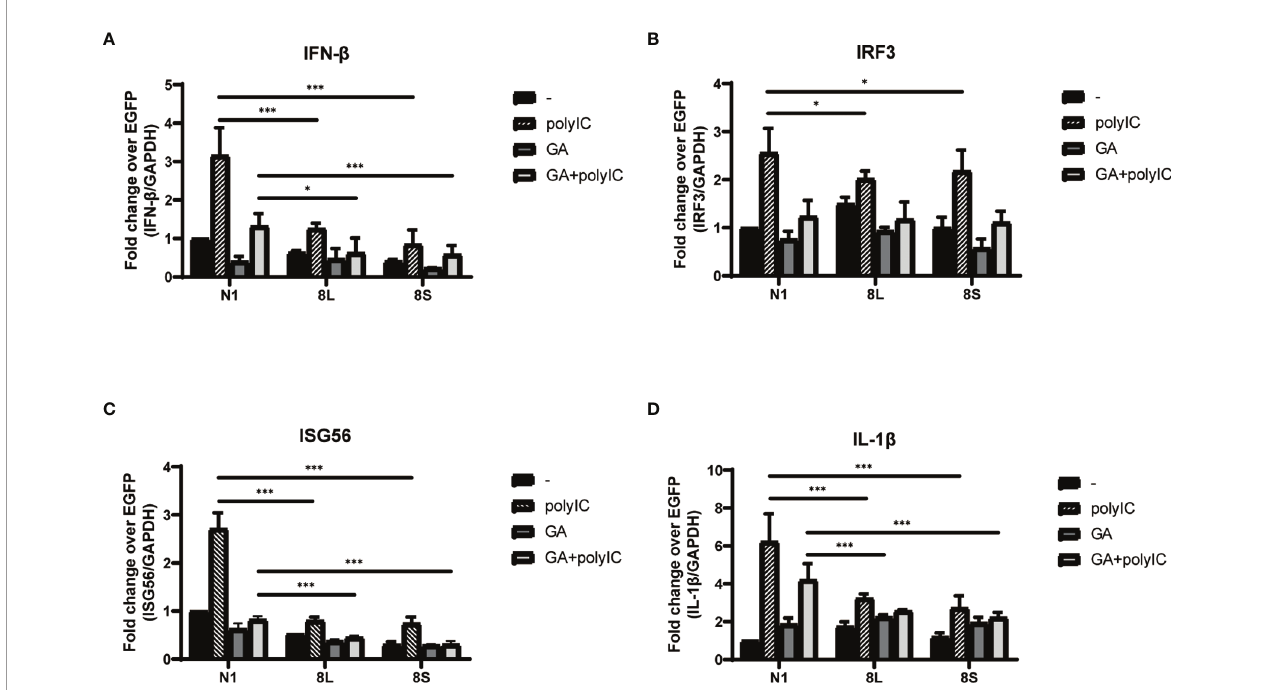
FIGURE 6 | The SARS-CoV-2 ORF8L and ORF8S suppress IFN response with antagonism of HSP90. (A – D) HeLa cells were seeded in 12-well plates for 12 h and incubated with GA (1 m M) for the succeeding 12 h, after which the indicated plasmids were transfected into HeLa cells and cells were treated with GA (1 m M) at 6 h post- transfection. After 24 h of transfection, the mRNA of cytokines in IFN pathways was examined by RT-PCR. *, P < 0.05; ***P < 0.001 versus empty vector (one-way ANOVA). Three independent biological replicates were analyzed, the results of one representative experiment are shown, and the error bars indicate the SD